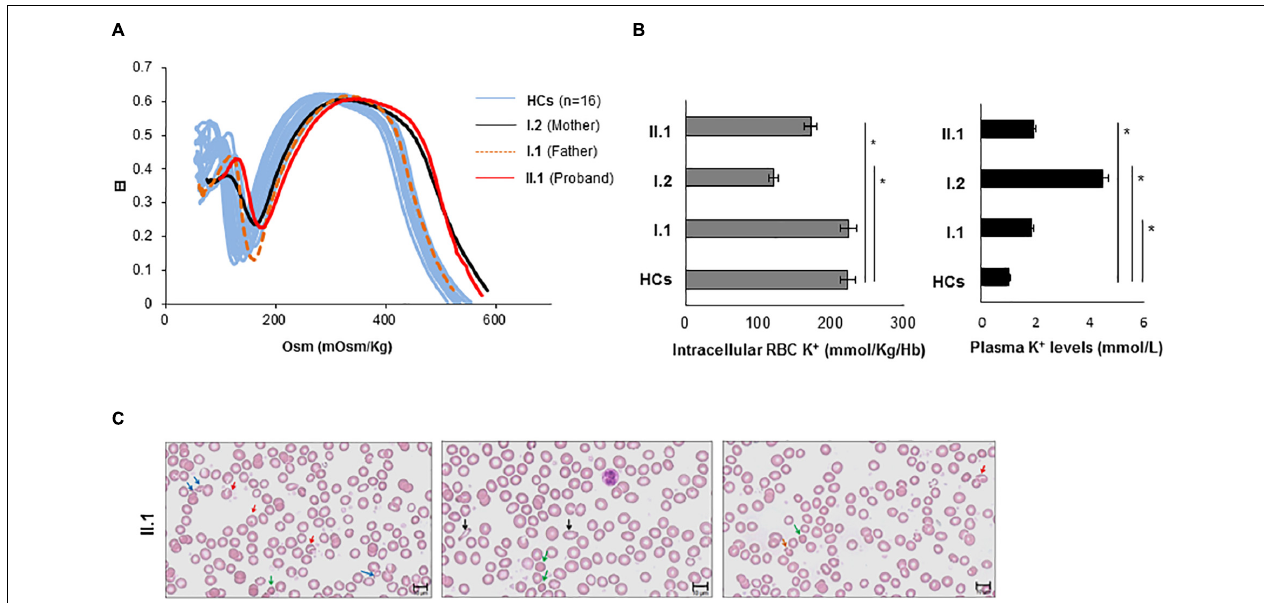
FIGURE 3 | Characterization of the hematological phenotype. (A) The red cell deformability index was measured as a function of increasing osmolarity of RBCs from proband II.1 (red line), from mother I.2 (black line), from father I.1 (orange dotted line), and internal HCs (light blue lines). Values are means +/– SE of two independent experiments. Elongation index (EI) (B) intracellular K+ content (expressed as mmol/Kg/Hb) of blood from II.1, I.1, I.2 subjects, and from HC (the graph with gray bars). Plasma K+ content (expressed as mmol/L of whole blood) of blood from II.1, I.1, I.2 subjects, and from HC (the graph with black bars) ∗ p -value < 0.05. (C) Peripheral blood smear (May-Grünwald Giemsa stain 40 × ) examination of the proband II.1 showing marked anisopoikolocytosis. Blue arrows indicate fragmented cells; red arrows indicate stomatocytes; green arrows indicate spherocytes; black arrows indicate ovalocytes; orange arrows indicate mushroom